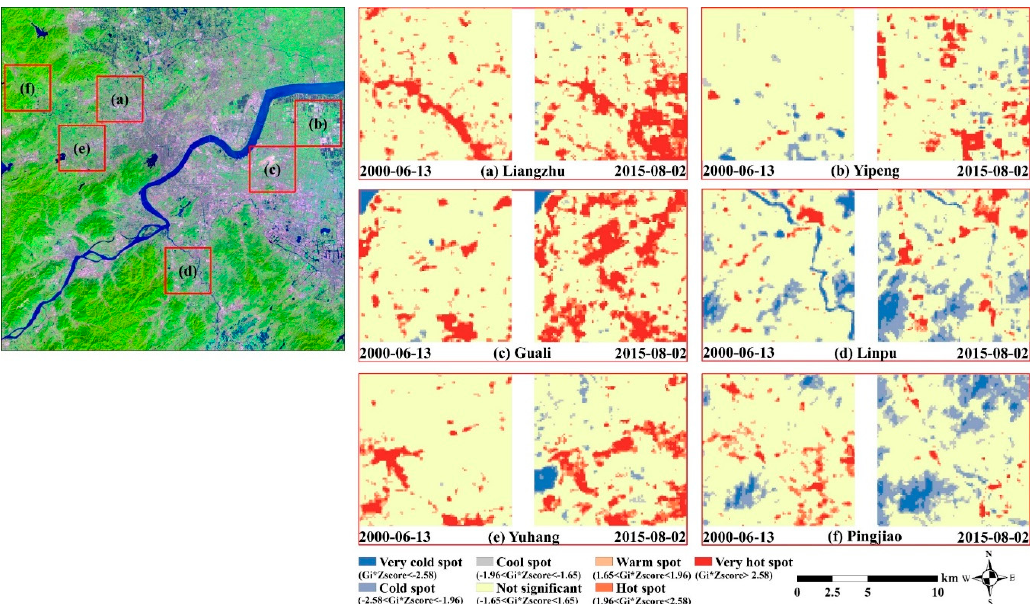
Figure 5. SUHI evolution of six main town groups.